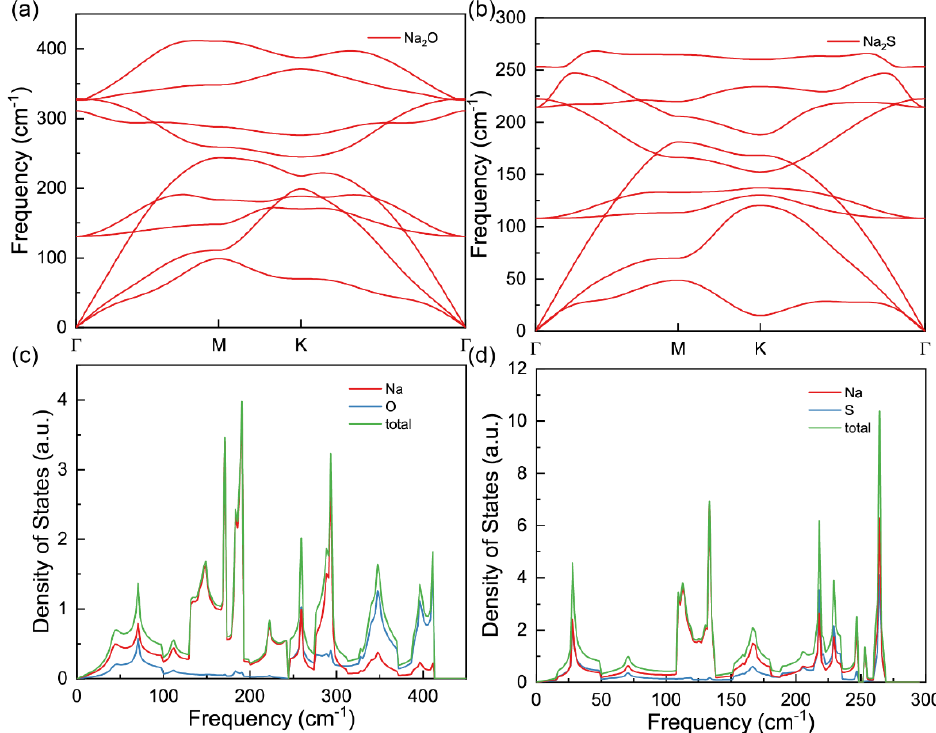
Figure 2. The phonon dispersions of ( a ) Na 2 O and ( b ) Na 2 S monolayers. The corresponding projected density of states of ( c ) Na 2 O and ( d ) Na 2 S monolayers.